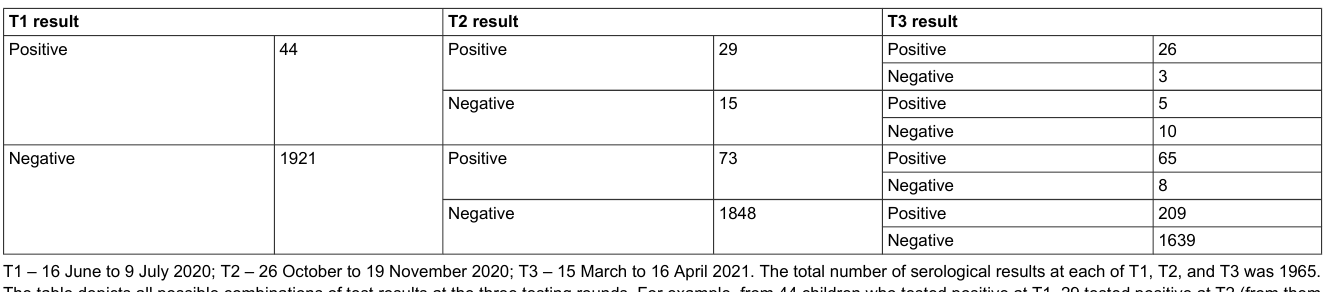
Table 1: Longitudinal serological results of children tested at all three testing rounds (n = 1965).